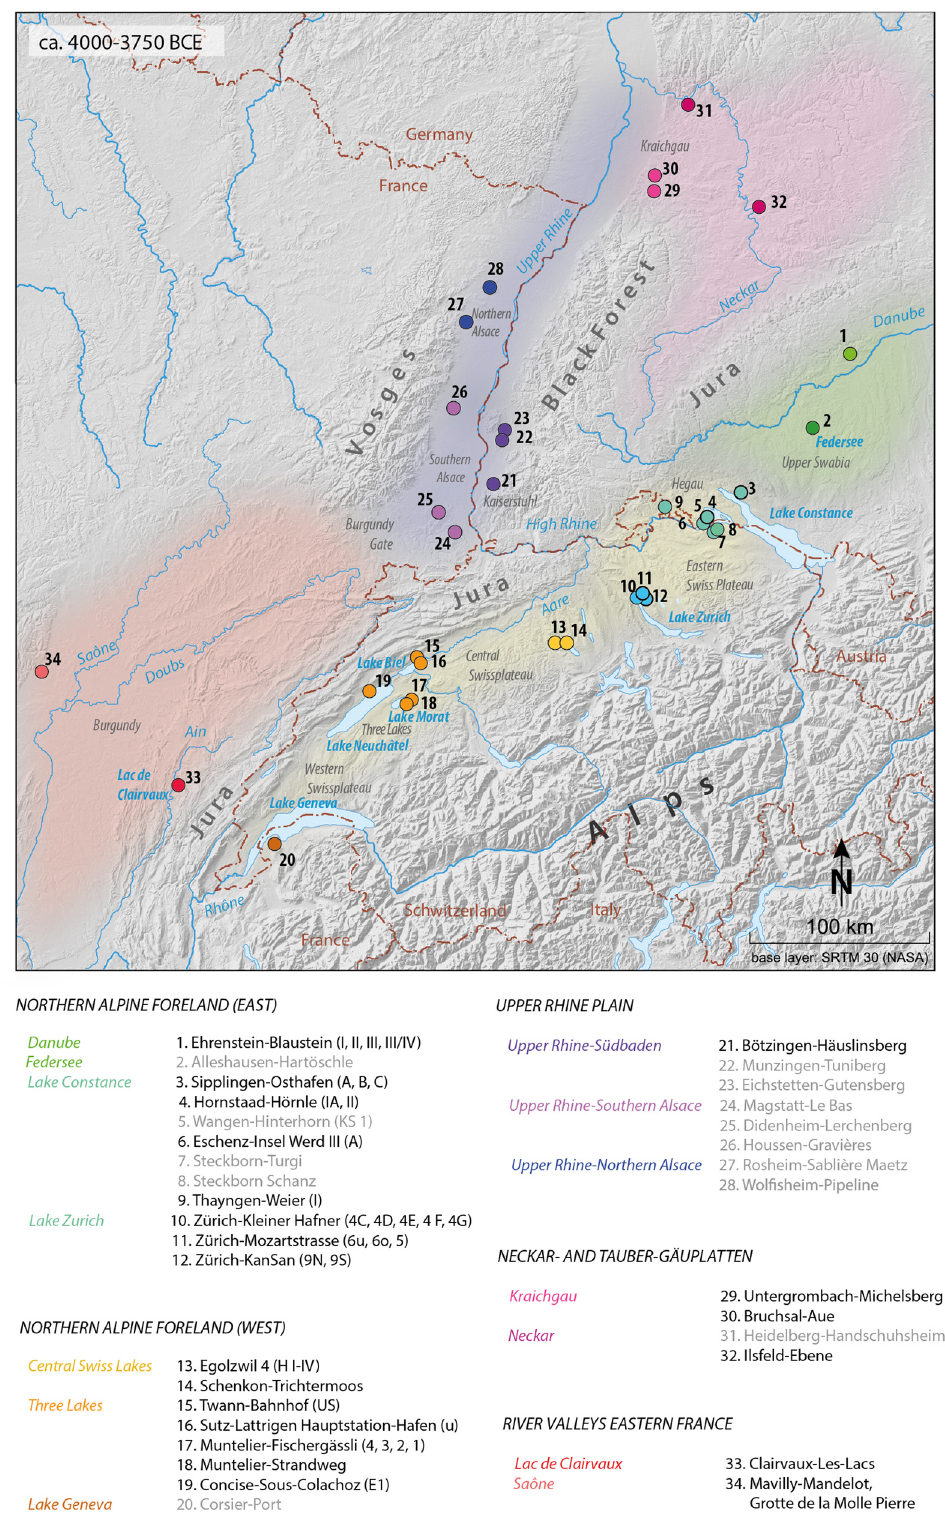
Figure 3: Selection of sites dating approx. 4000 – 3750 BCE and their geographical location in the northern Alpine Foreland and adjacent regions, highlighted in black: sites with pottery assemblages used in this paper for the unsupervised classi fi cation approach ( fi gure: C. Heitz., map base according to Jammet - Reynal, 2017 )